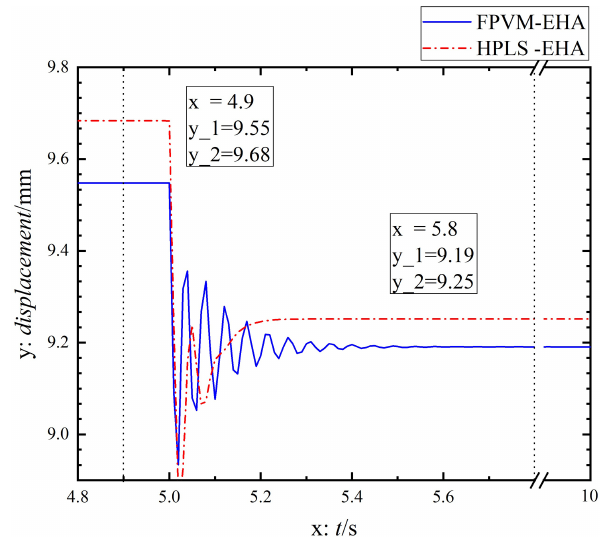
Figure 14. Contrast diagram of output position of actuator (4.8–